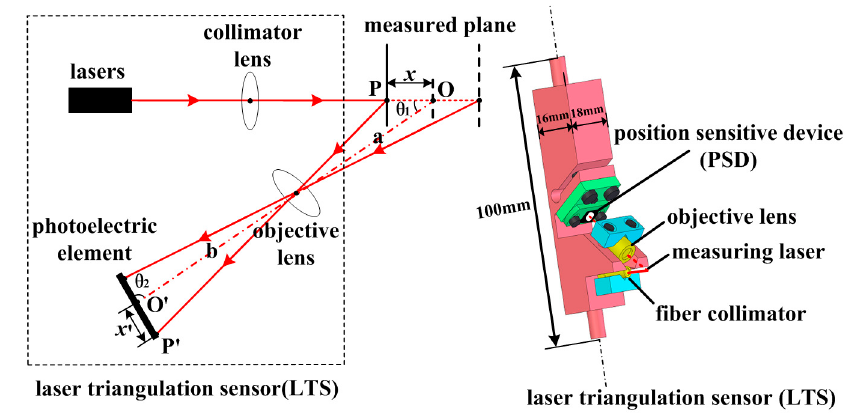
Figure 1. Principle of laser triangulation sensor.